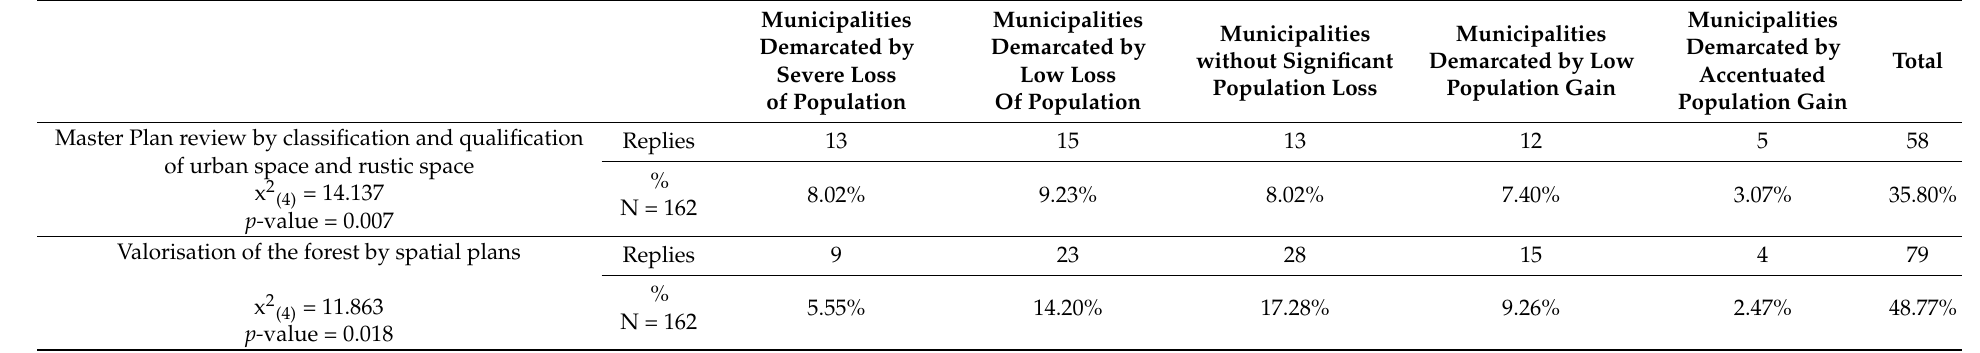
Table 7. Relationships with statistical significance established between the considered opportunity of Master Plan review by classification and qualification of urban space and rustic space and valorisation of the forest by spatial plans , and the degree of depopulation between